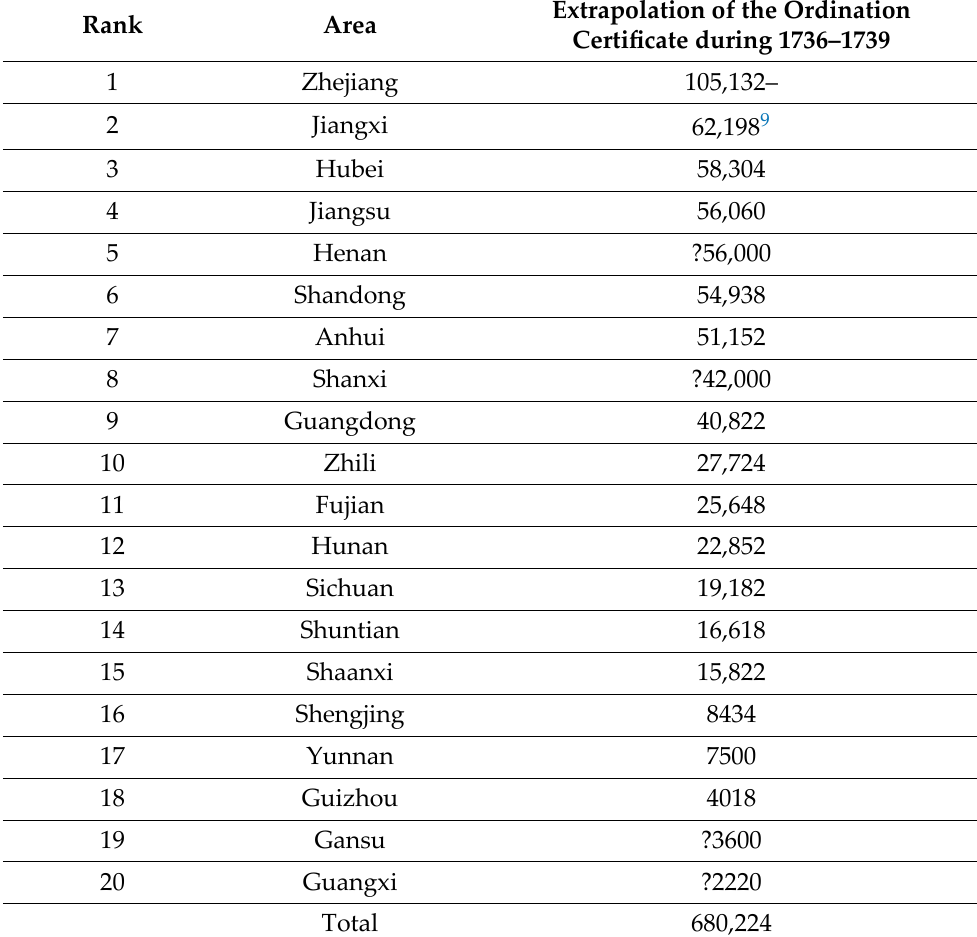
Table 4. The author’s estimation of the actual number of monks in each province in the mid‑18th